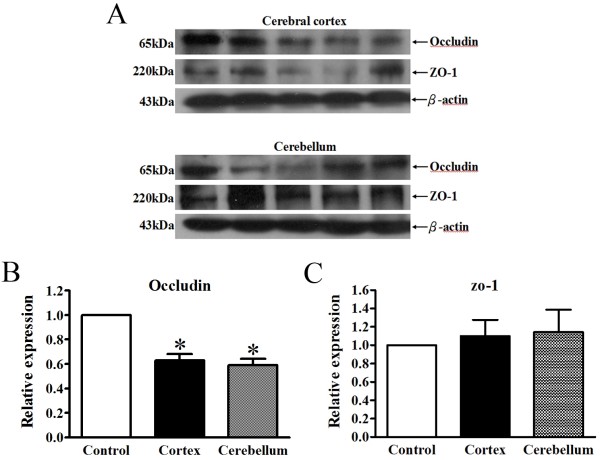
Expression of tight junction protein, occludin, was decreased in the brains of rabies-infected rats. Western blotting analyses of tight junction proteins, occludin and ZO-1, were shown in (A) the cerebral cortex and cerebellum. Relative levels of tight junction protein (B) occludin and (C) ZO-1 expression were determined by densitometric analysis. All samples analyzed (n = 4) were normalized to the intensity of corresponding β-actin bands. Results are expressed as mean ± SEM. *p < 0.05, significantly different from the control rats.